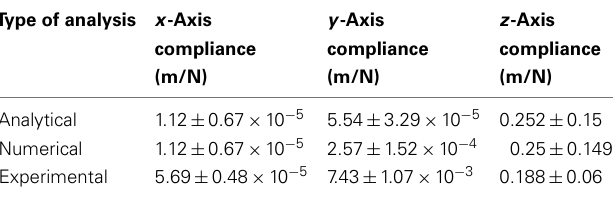
Table 4 | Matrix comparing the serpentine cable compliance estimated through analytical, numerical, and experimental analysis.